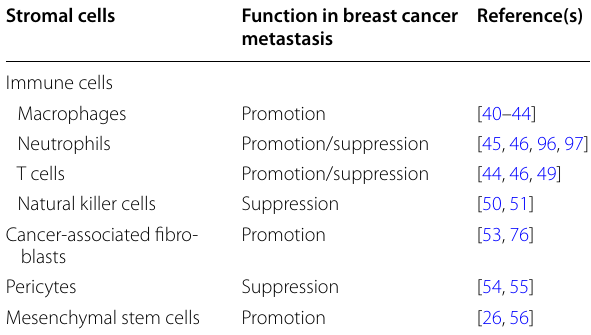
Table 2 Stromal cells in breast cancer